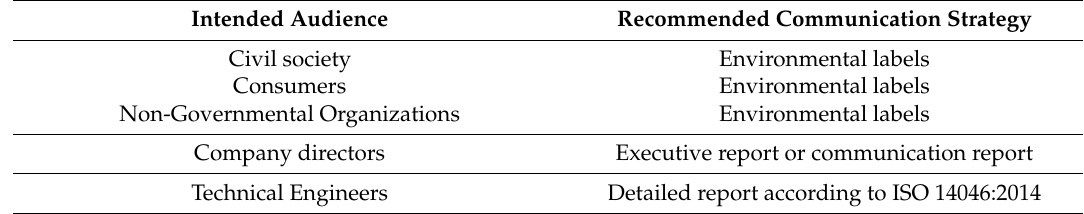
Table 6. Recommendations for good practices during the communication of the results of water footprint studies in Latin America. Modified from CADIS-COSUDE (2016)